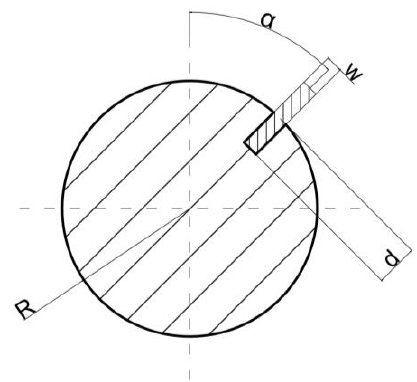
Figure 5. Utilized description of the tested object cross-section as a cylindrical object with a rectangu- lar notch and marked parameters. R—object radius, d—depth of the notch, w—width of the notch, α —initial angular position of the notch with respect to the coil axes.